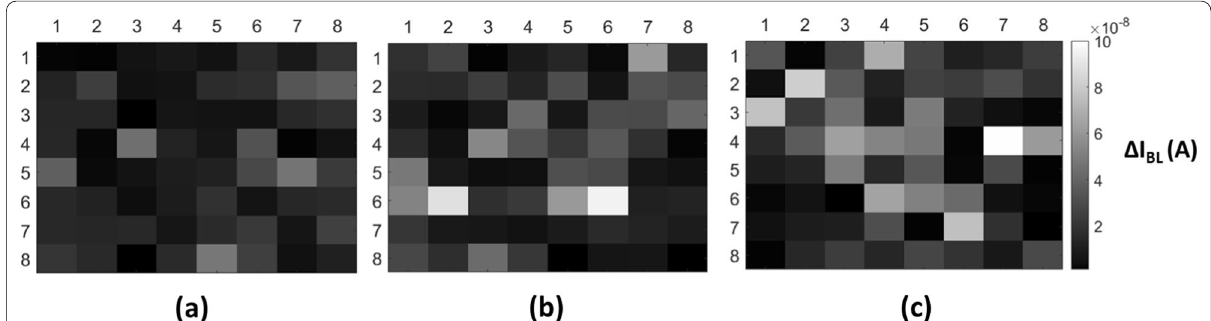
Fig. 7 The two‑dimensional images after 30 keV e‑beam exposure with a dosage of a 0.2μC/cm 2 , b 0.6μC/cm 2 and c 1μC/cm 2 , respectively